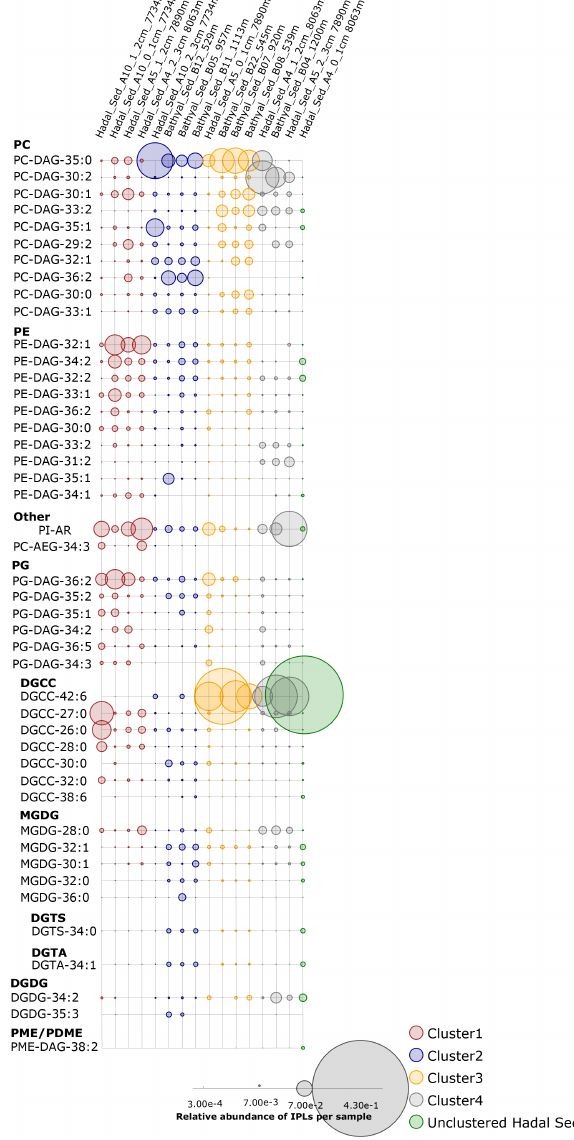
Figure 3. Relative abundance of individual IPLs contributing most of the dissimilarity between the four clusters shown in Fig. 2. Sam- pling stations are organized left to right and are shown using the same order from hierarchical clusters in Fig. 2, whereas IPL classes are organized from top to bottom. The circle size is proportional to the relative abundance of IPLs in each sample (bottom